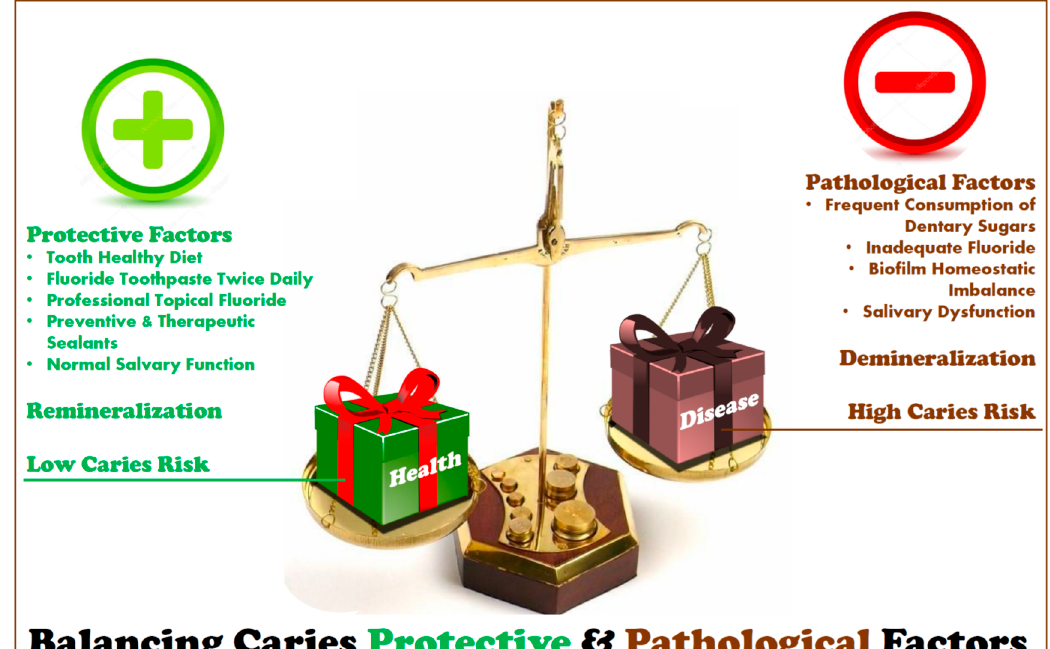
Figure 6. Diagram of the dynamics of interactions between protective and pathological factors that can shift the balance in the oral cavity towards health or disease, respectively.